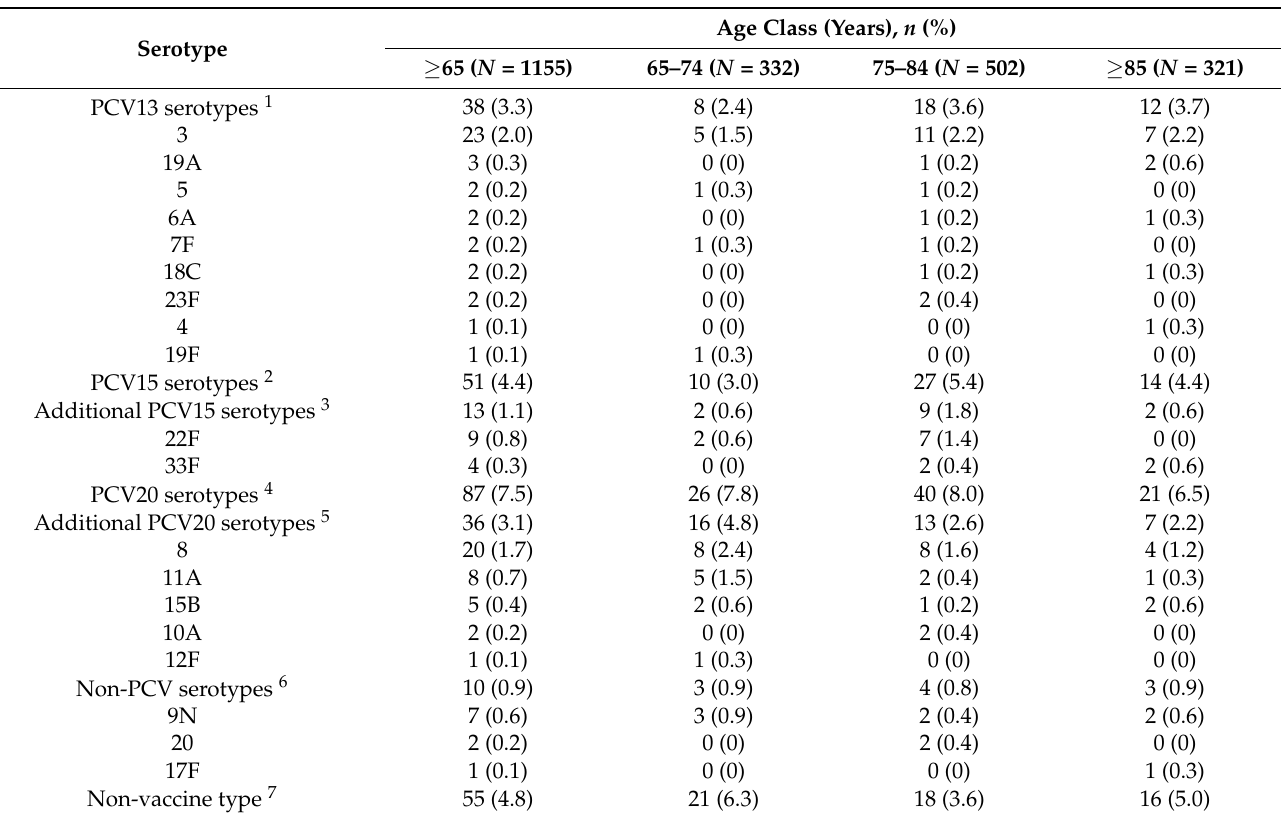
Table 2. Percent of all community-acquired pneumonia cases due to individual serotypes and grouped by pneumococcal conjugate vaccine (PCV)